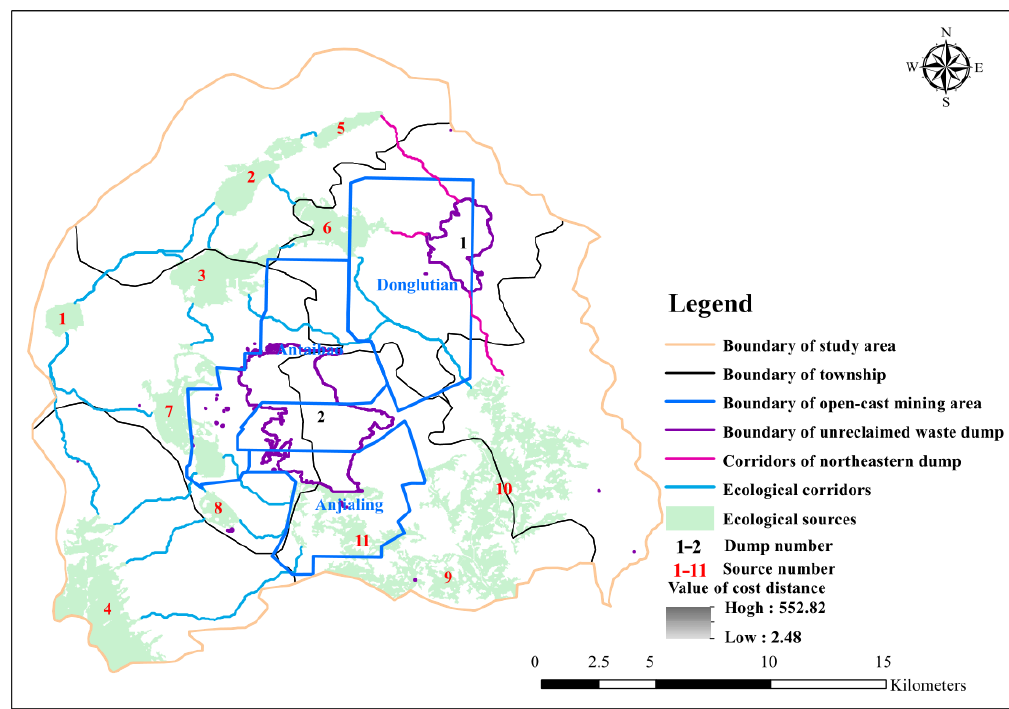
Figure 9. The optimization of stripped area.